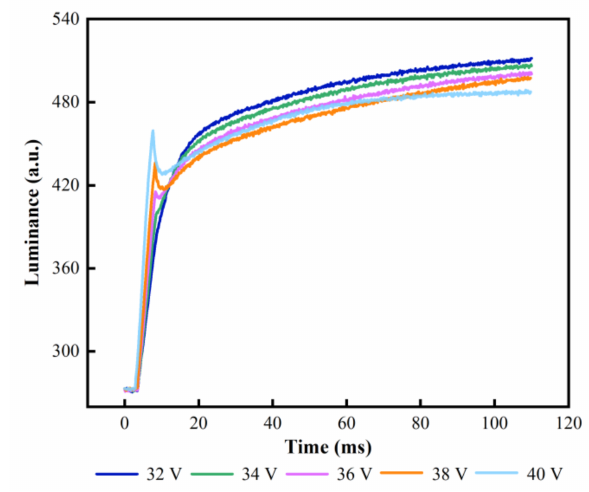
Figure 7. Luminance-time curves of different V max s. Luminance-time curves of different V max s. With the increase of V max , the luminance gradually decreased and luminance mutations of varying degrees begin to appear. The maximum luminance was 511 when V max was 32 V.